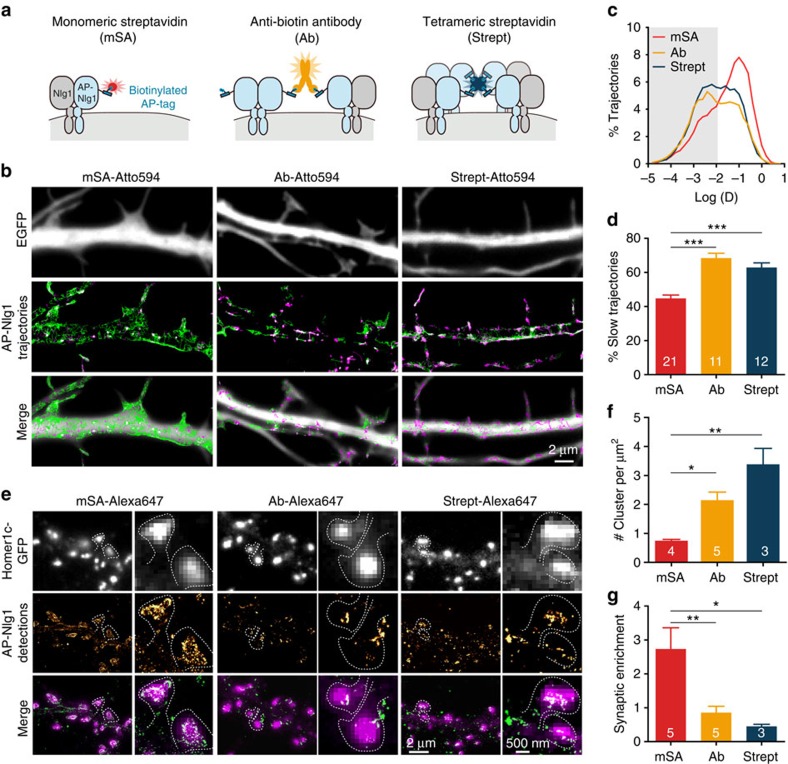
Super-resolution imaging of AP-Nlg1 with mSA or biotin antibody or tetrameric streptavidin.(a) Schematic diagram of AP-Nlg1 labelled with three different probes (mSA, monoclonal biotin antibody or streptavidin), conjugated to Atto 594 for uPAINT or Alexa 647 for dSTORM. (b) Examples of DIV 7 neurons co-expressing EGFP as a volume marker, AP-Nlg1 and BirAER, and labelled as described above. Middle panels display AP-Nlg1 trajectories calculated from stacks of 4,000 images with 20-ms exposure time (green: fast-diffusing pool, that is, D>0.01 μm2 s−1; magenta: slow diffusing pool, that is, D<0.01 μm2 s−1). Merged images show EGFP (grey) overlaid with AP-Nlg1 trajectories. Note that mSA explores larger surface areas with faster diffusion than multivalent ligands. (c) Distribution of AP-Nlg1 diffusion coefficients in a semi-log plot, where the grey-shaded area represents slow trajectories (that is, with D<0.01 μm2 s−1). (d) Corresponding percentage of slow trajectories measured in the three different conditions (***P<0.0001). Data are from three different experiments. (e) Examples of DIV 15 neurons co-expressing Homer1c-GFP, AP-Nlg1 and BirAER, and labelled with the three Alexa647-conjugated probes shown in a. Top panels: Homer1c-GFP signal showing mature synapses (white). Middle panels: super-resolved AP-Nlg1 detection maps generated from 40,000 frames with 20-ms integration time. Bottom panels: merged images showing AP-Nlg1 detections (green) overlaid with Homer1c-GFP (magenta). Note the presence of large AP-Nlg1 aggregates in anti-biotin and streptavidin-labelled neurons. (f) Histogram showing the number of Nlg1 clusters per μm2 in the three conditions (**P<0.01). (g) Histogram showing the synaptic enrichment of AP-Nlg1 compared with the shaft (**P<0.01, *P<0.05). Data are from two different experiments. Numbers in the bar charts represent the number of cells examined.